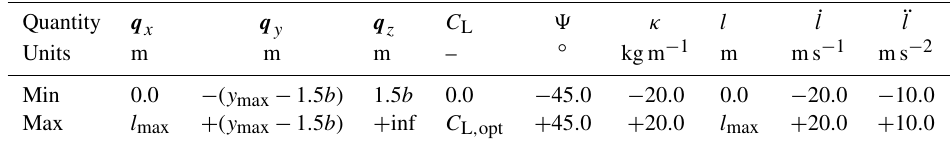
Figure 3. Power-optimal trajectories of (a) lift- and (b) drag-mode AWE systems optimised for the range of wind speed U D ∈ [ 5 . 0 , 12 . 0 ] by solving the optimal control problem (Eq. 33) under consideration of the variable constraints given in Tables 1 and 2. The maximal streamwise extent of each trajectory does not exceed 1000m, but for the sake of visualisation the positions of successive ground stations were shifted by 1000m. Table 1. Bound constraints applied to state variables x used in the optimal control problem (Eq. 33). The maximal lateral extent of the flight path and the maximal tether length are respectively set to y max = 250m and l max = 1000m to limit the footprint of the trajectories. The optimal value of the lift coefficient is C L , opt = 1 .